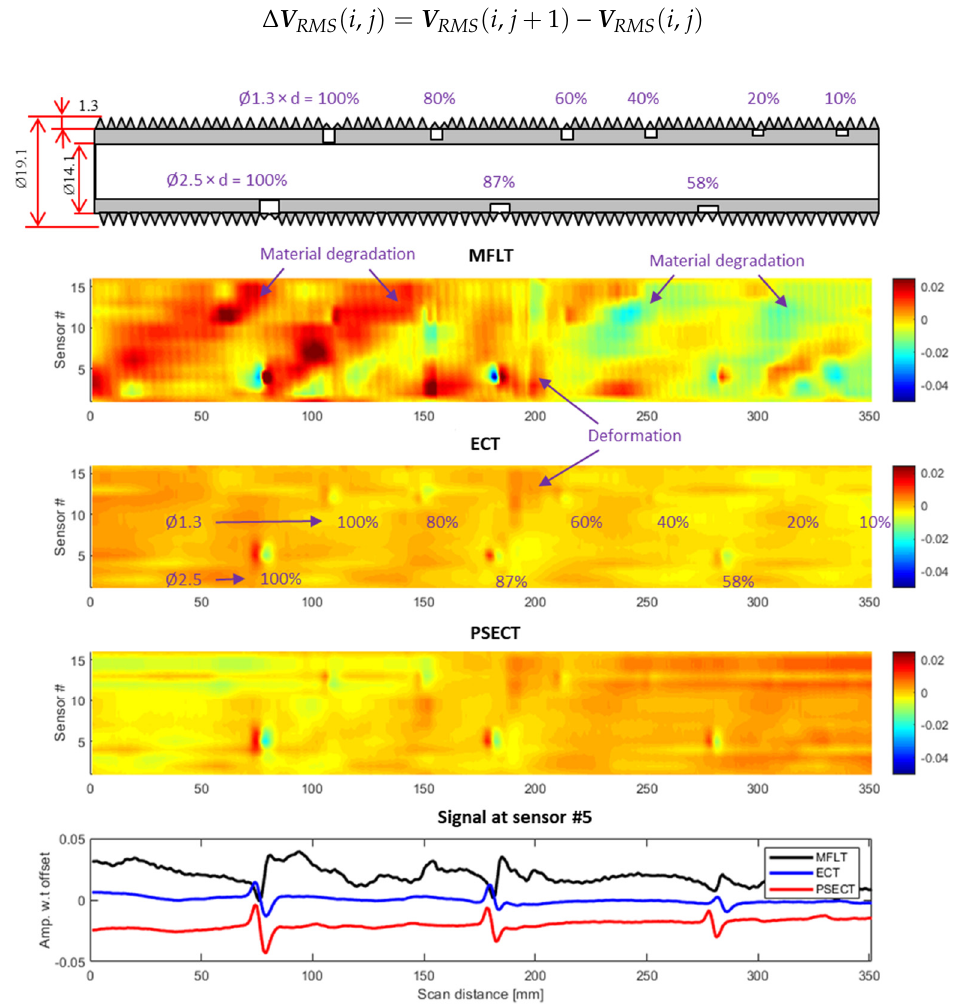
Figure 4. Mean subtraction of magnetic scanned image of the MFLT, ECT and PSECT methods on the MSR finned tube and the section view at the holes of 2.5 mm diameter (sensor #5).